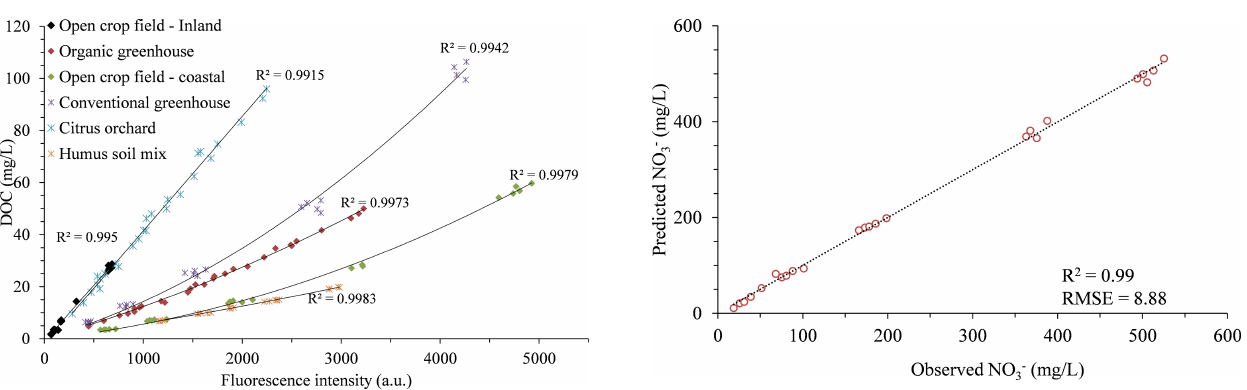
mus soil mixture water extract, when the calibration equation was obtained for absorption at 235nm using a standard laboratory spec-